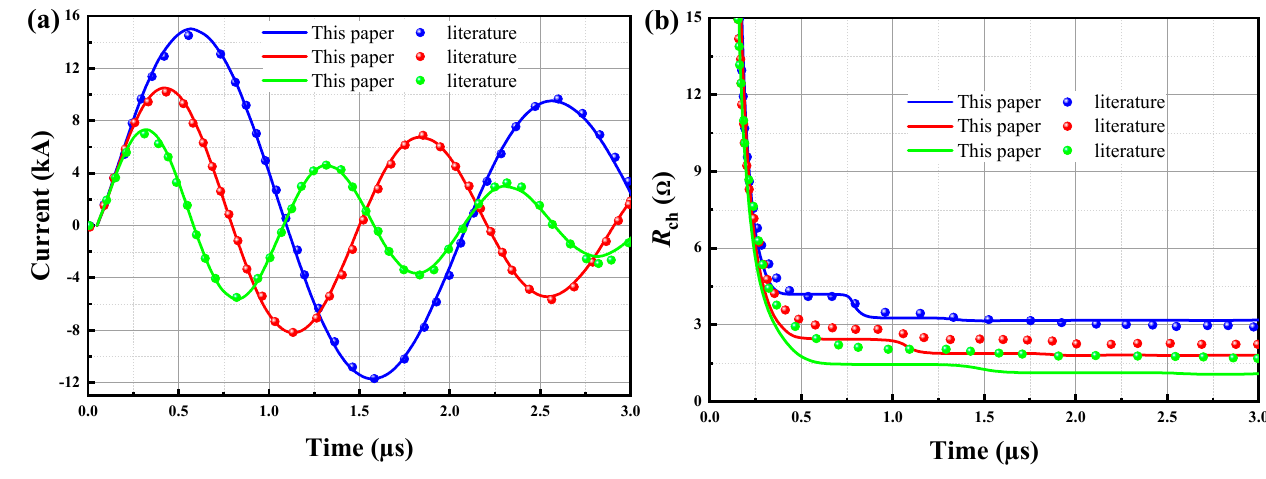
Figure 13. Validation of this paper’s results against the simulation results from Literature [4] for the electric pulse loop. ( a ) Wave form of current I and ( b ) channel resistance R ch , where U 0 = 280 kV, L = 5 µH, l = 2.5 cm, C (nF): blue line—5, red line—10, green line—20.